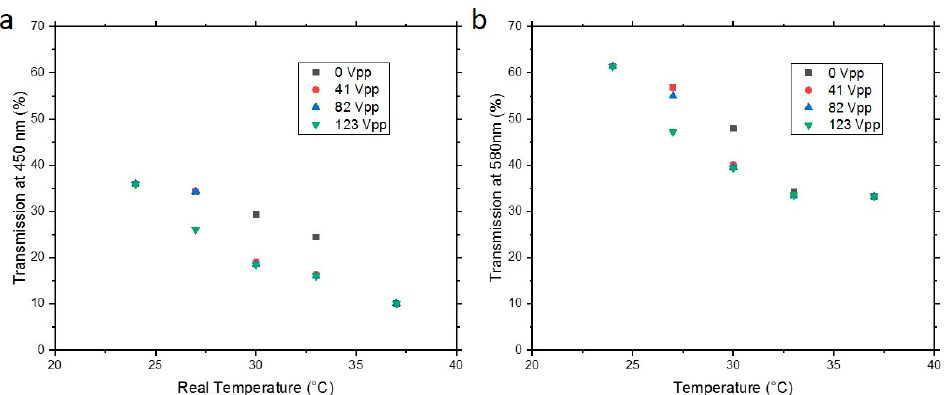
Figure 6. Peak transmission of an interdigitated homeotropic cell as a function of temperature and voltage filled with 8CB and 1 wt% of ( a ) Dye 1; ( b ) Dye 2.